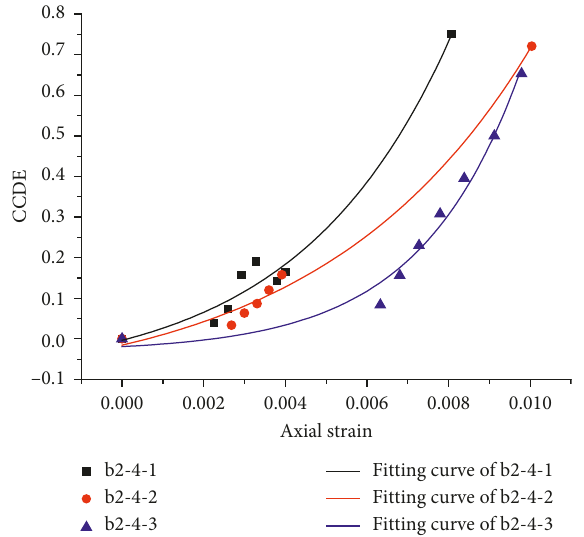
Figure 11: Relation curves of the CCDE and the axial strain for b2 rock specimens.